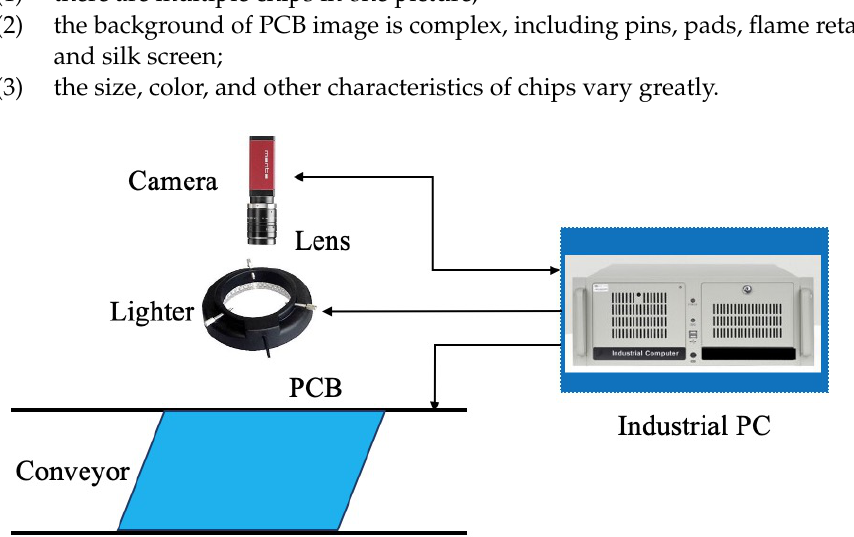
Figure 1. Electronic chip detection system.